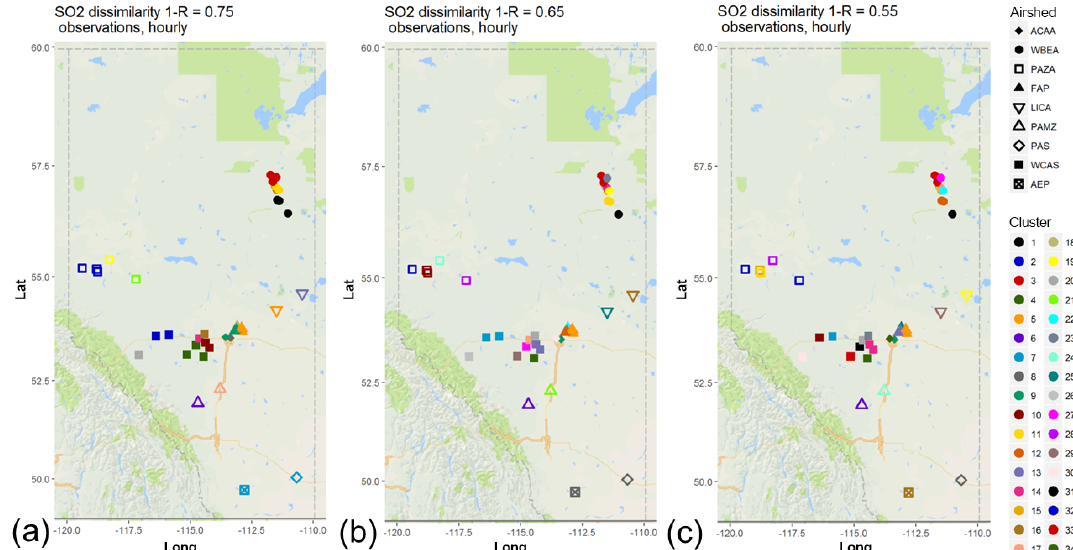
Figure 4. Associativity analysis for observed SO 2 hourly time series using 1 − R as the metric to compute the dissimilarity matrix, assuming a dissimilarity level of (a) 0.75, (b) 0.65, and (c) 0.55. Stations are colour-coded by cluster, and airsheds are plotted with different polygons. The acronyms for the airsheds are as in Fig.